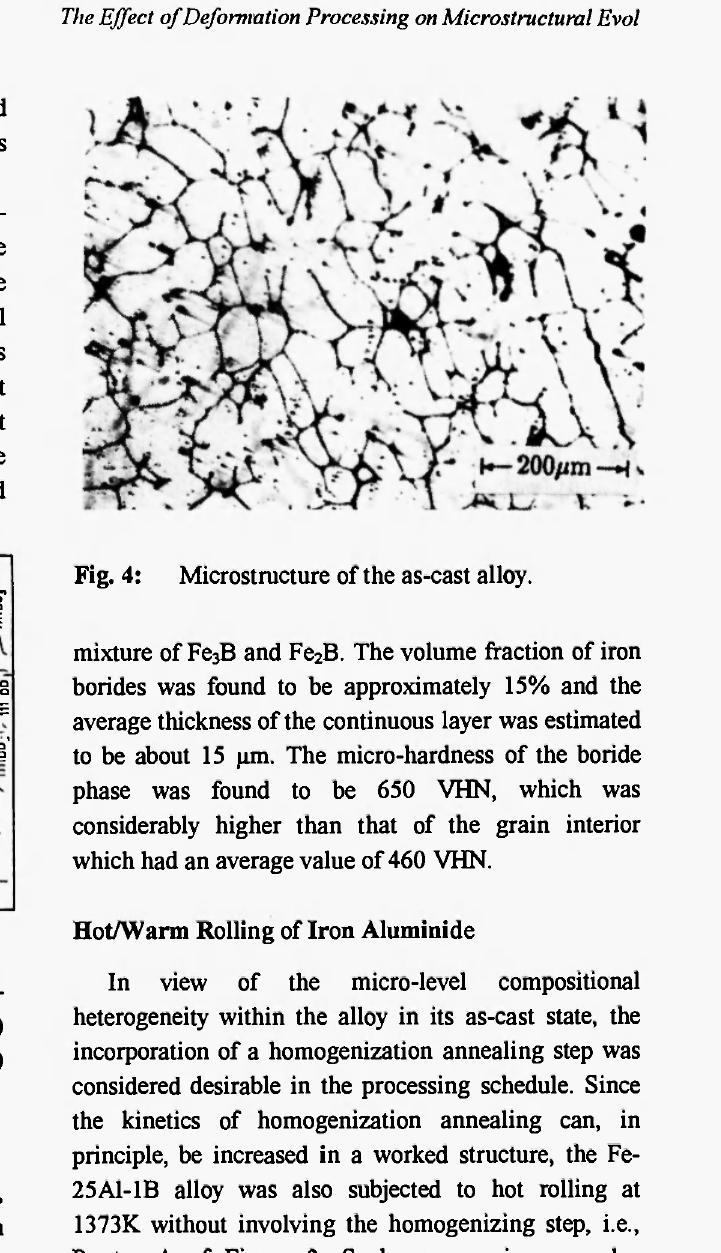
Fig. 3: X-ray diffraction patterns from the Fe-25A1- 1B alloy in (a) as-cast, (b) homogenized, (c) rolled at 1073K, (d) rolled at 773K and (e) ordered at 623 conditions.